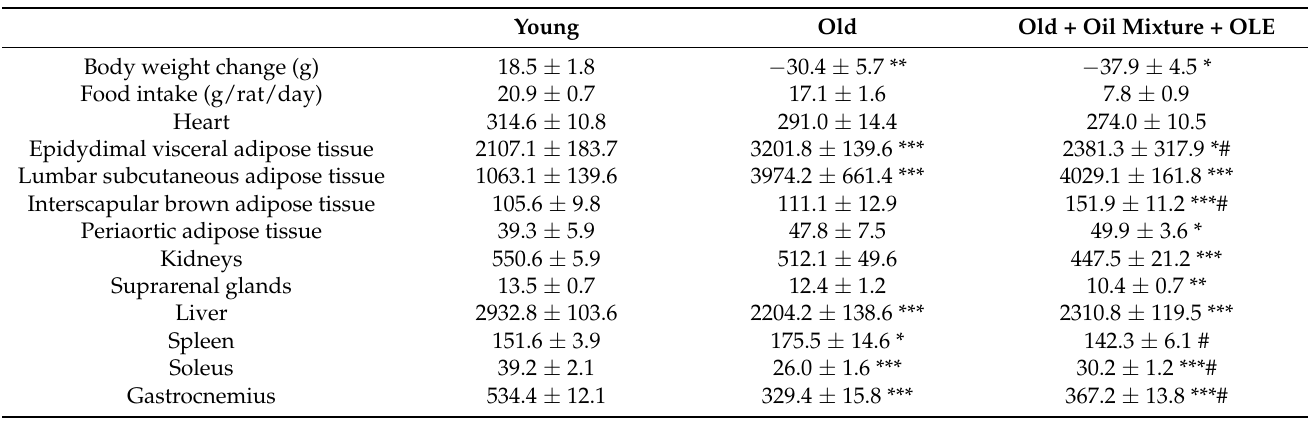
Table 2. Body weight change, food intake and relative organ weights (mg/100 g body weight) of young rats, old rats and old rats treated with the oil mixture and the